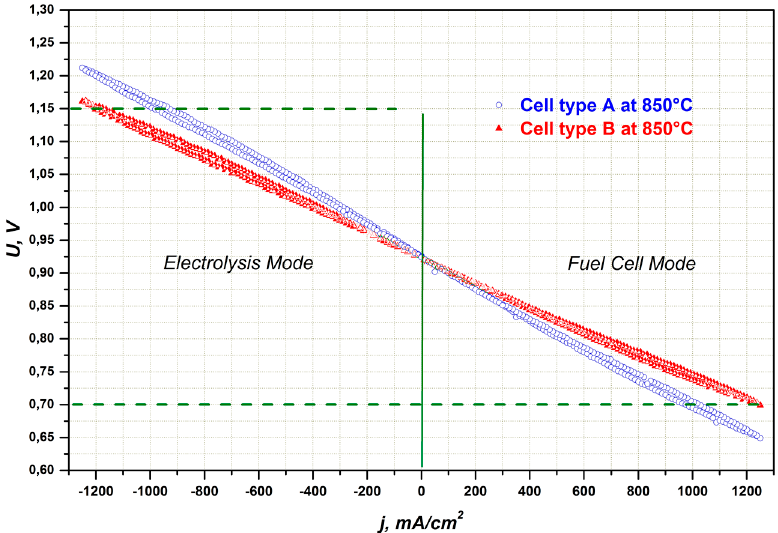
Figure 6. I–V characteristics of cells with 8YSZ (type A) and ScSZ (type B) interlayers measured in both electrolysis and fuel cell mode at different temperatures under H 2 /H 2 O = 50/50. Table 2. Changes of cell voltage and ASR for different cells during the long-term galvanostatic operation in electrolysis mode in a H 2 /H 2 O mixture with a molar ratio of